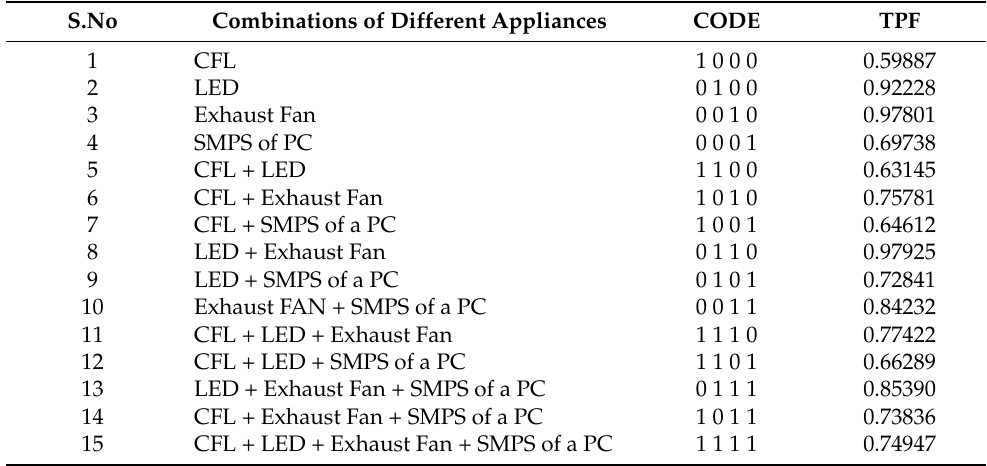
Figure 5. The voltage and current waveforms of a single real-world appliance: ( a ) CFL, ( b ) LED, ( c ) exhaust fan, and ( d ) SMPS of a PC. Table 2. TPFs for all 15 appliance patterns in real time.